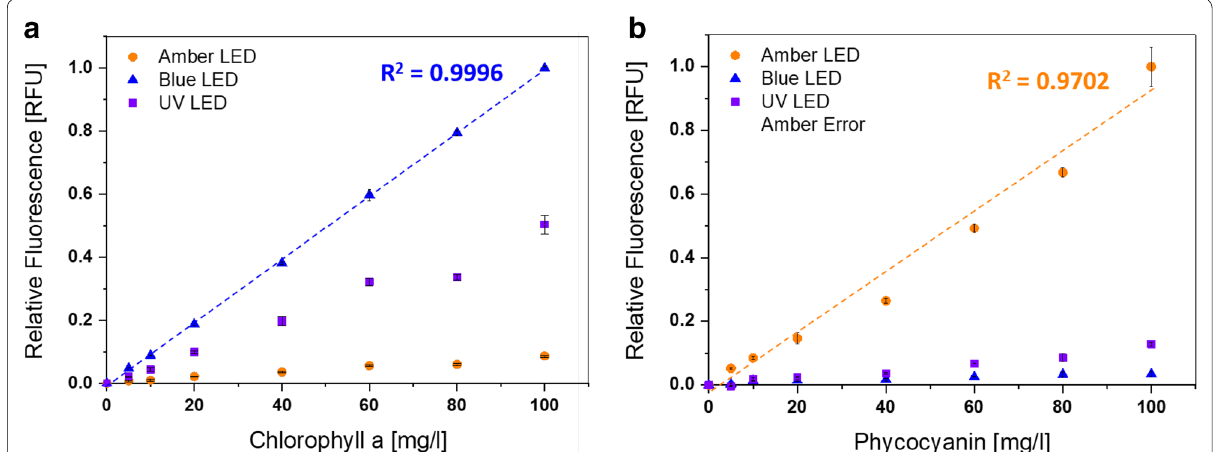
Fig. 3 Measured photocurrent of the fluorescence emission from the a chlorophyll a and b phycocyanin using three different excitation LEDs. The error‑bars represent the standard deviation of a data set (n